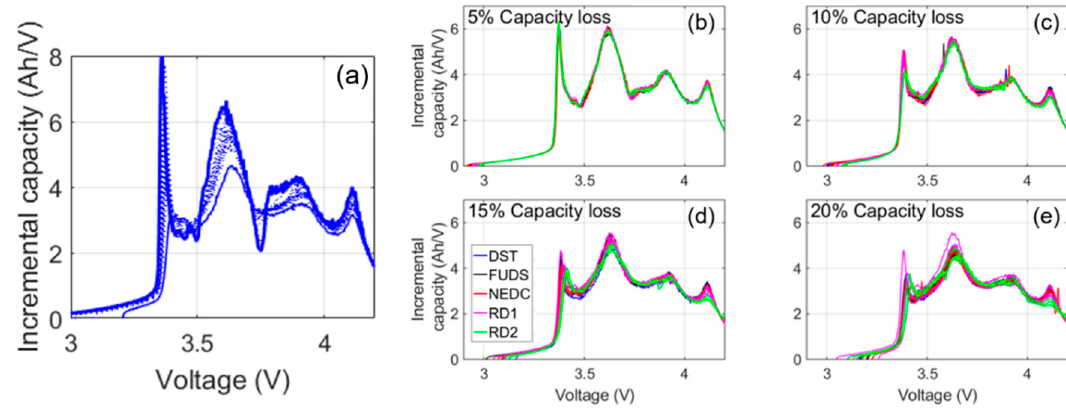
Figure 4. ( a ) Representative incremental capacity (IC) curve evolution up to 20% capacity loss. ( b – e